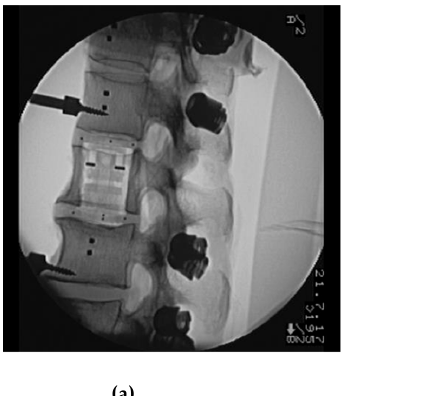
Figure 3. Prototype of the non-metallic, X-ray-translucent CF/PEEK expandable VBR. icotec, Altstätten, Switzerland.